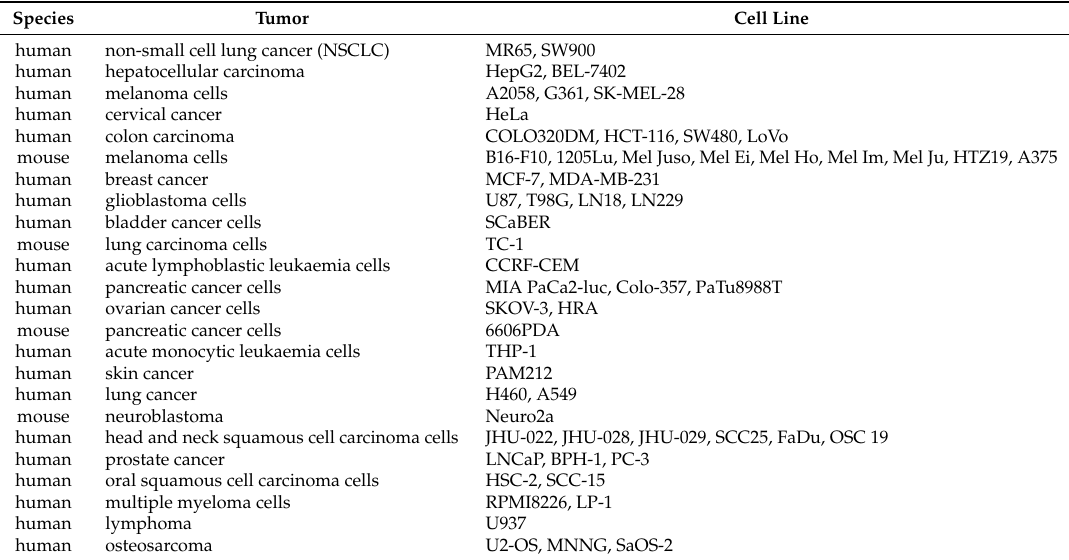
Table 1. Cancer systems used for investigating cold atmospheric plasma (CAP)